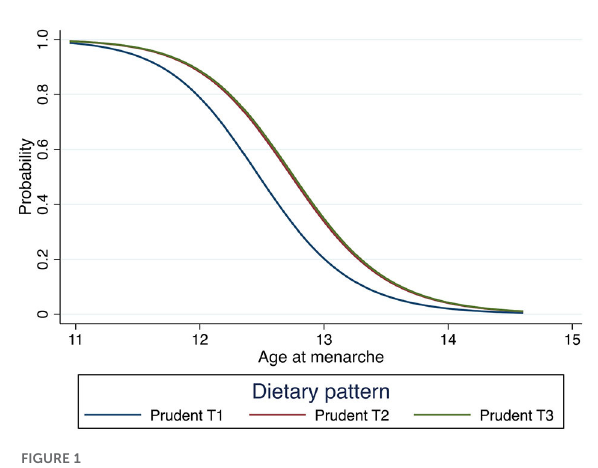
FIGURE1 Survival curve of age at menarche of each of the tertiles of the “Prudent” dietary patterns in 215 girls from the Growth and Obesity Chilean Cohort Study. Model adjusted by z -score BMI maternal age at menarche and total usual energy intake.